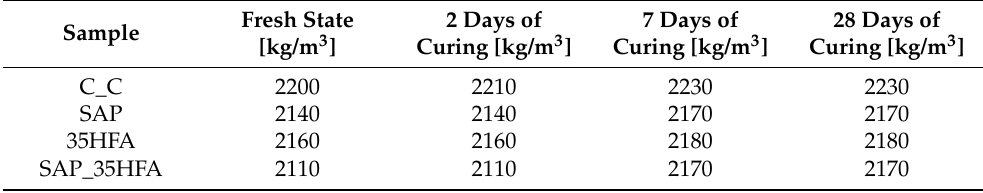
Table 6. Volumetric weight of test samples.